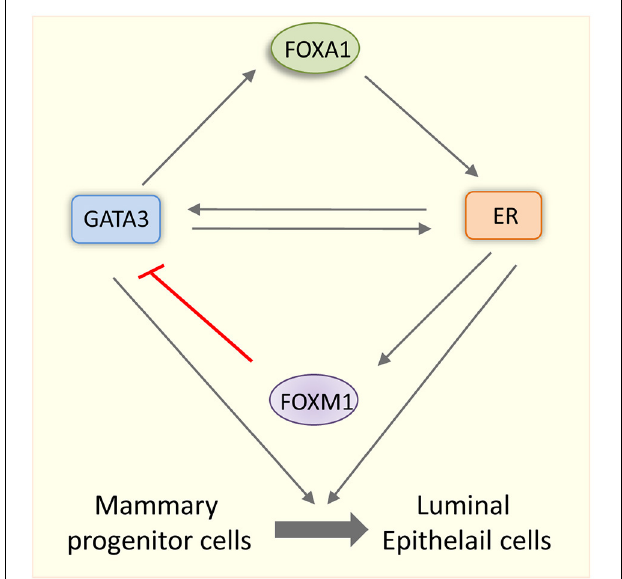
FIGURE 3 | Interdependence of pioneer factors and ER specifies mammary cell fate. Schematic representation showing the interplay among ER, GATA3, FOXA1, and FOXM1 in mammary gland cell fate. GATA3 and ER regulate each other’s transcription positively. GATA3 also regulate FOXA1 transcription and FOXA1 in turn upregulates ER in epithelial cells. ER transcriptionally upregulates FOXM1 and FOXM1 in turn down regulates GATA3. Luminal lineage specific factors such as FOXA1, GATA3, and ER specify the fate mammary progenitor cells and promote their differentiation into luminal epithelial